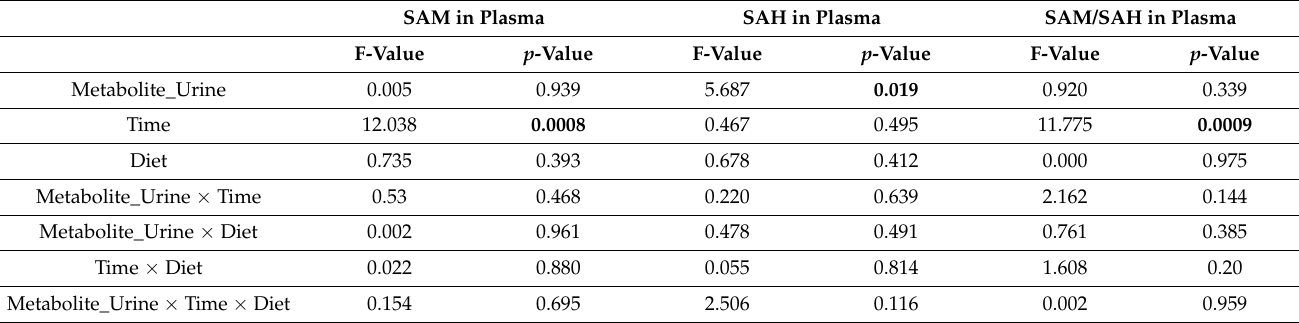
Table 7. Results of the multiple linear regression analysis of SAM, SAH, and SAM/SAH in plasma and urine. Entries highlighted in bold font are statistically significant ( p -value <